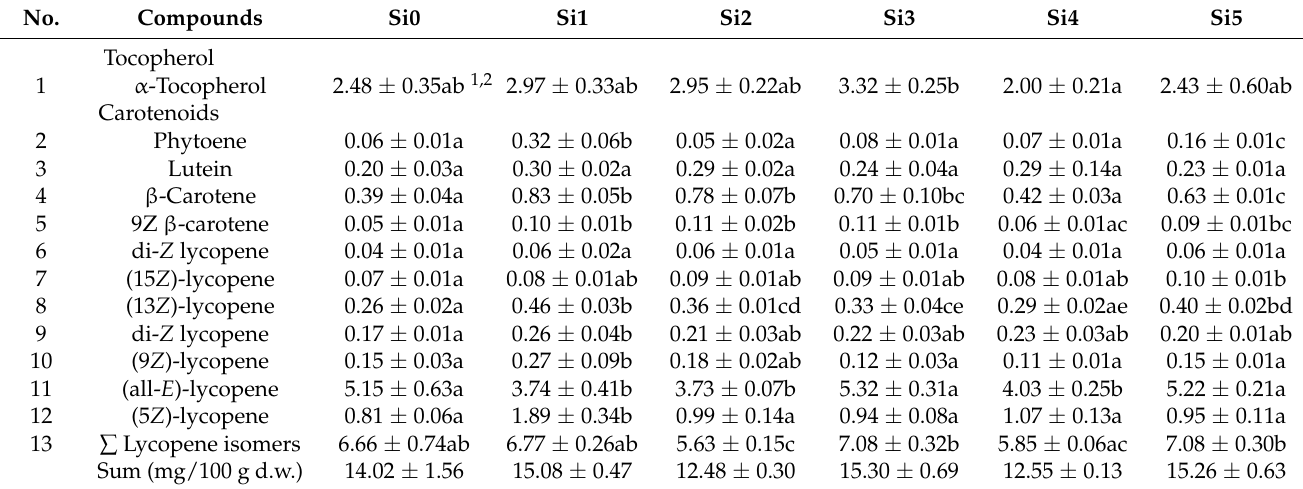
Table 3. Quantification of tocopherols and carotenoids (mg/100 g d.w.) in the seeds of cherry silverberry.